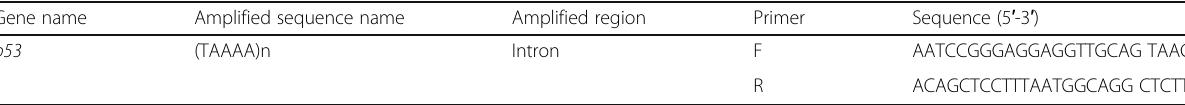
Table 1 Primer sequences for TAAA repeated sequence in the p53